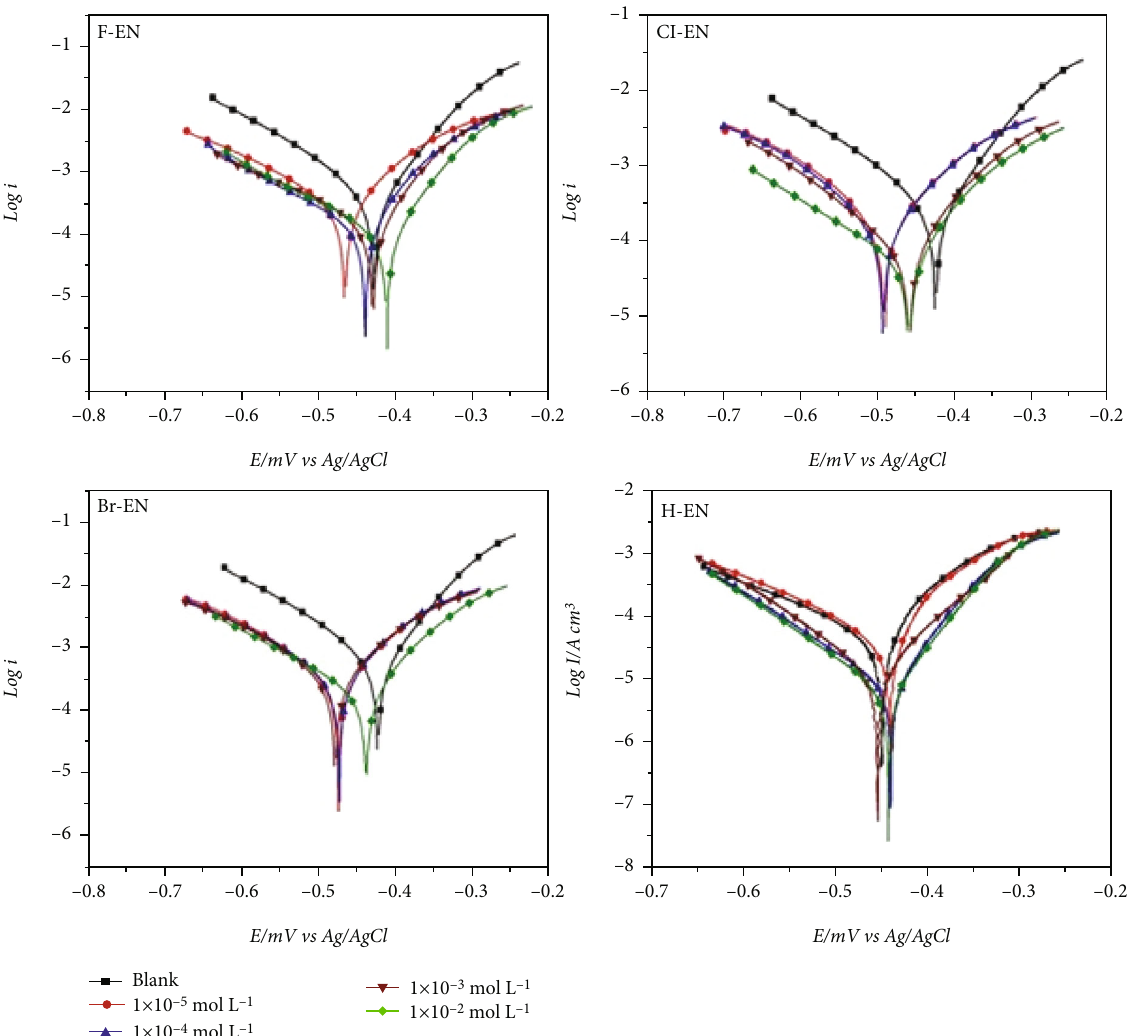
Figure 5: Polarization curves in absence and presence of inhibitors against AISI 1020 carbon steel in 1.0 molL -1